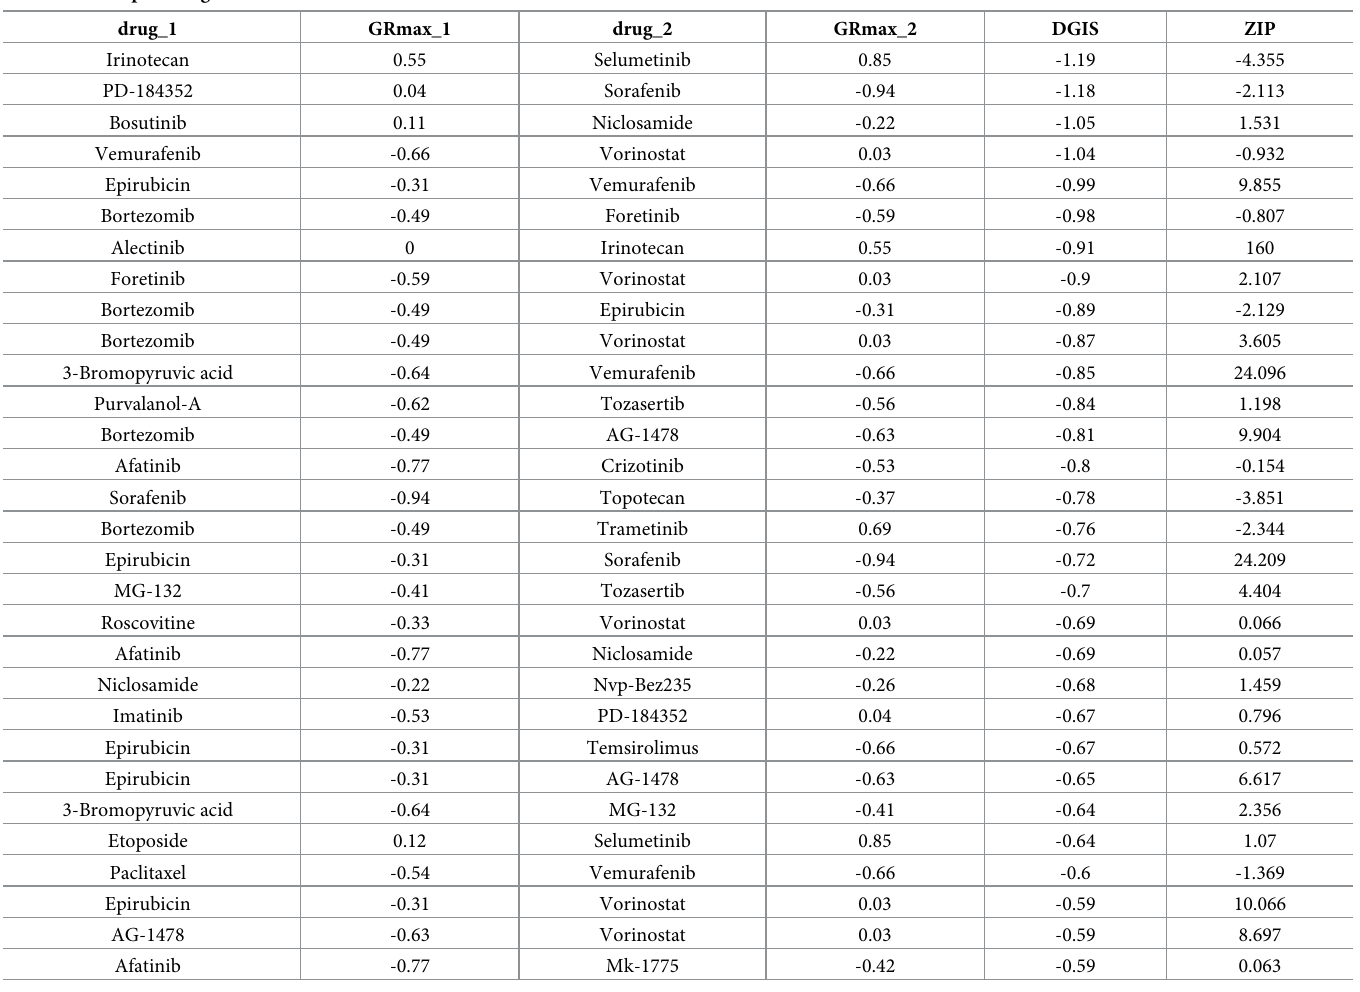
Table 1. The top 30 drug combination